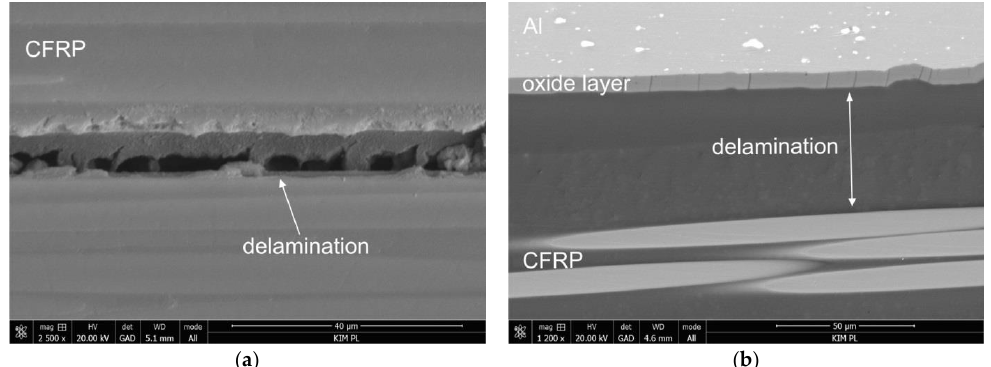
Figure 7. Types of damage in one-sided laminates with an additional layer of glass composite (Al-GC) before ( a ) and after ( b ) hygrothermal conditioning.